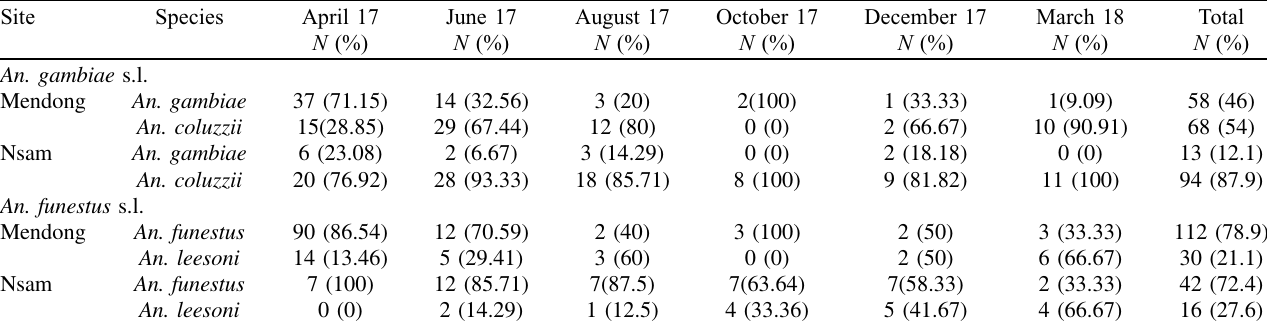
Table 3. Mosquito species composition in Nsam and Mendong, Yaoundé, from April 2017 to March 2018. Species Nsam Mendong CDC-LT HLC Total Aedes sp. Mansonia sp. An. ziemanni